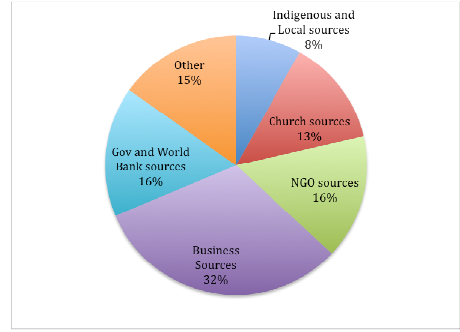
Figure 4: Distribution of sources used in articles about Canadian mining companies in